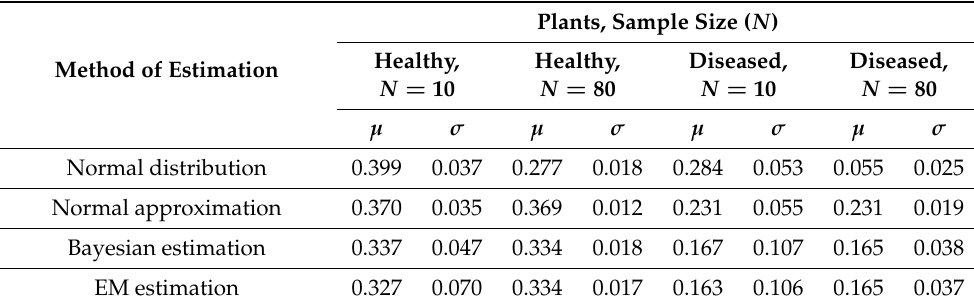
Table 10. The mean value ( µ ) and the associated standard deviation ( σ ) of the fourth-order fractional moment of the Monte Carlo simulation with 24 h as a reference value.